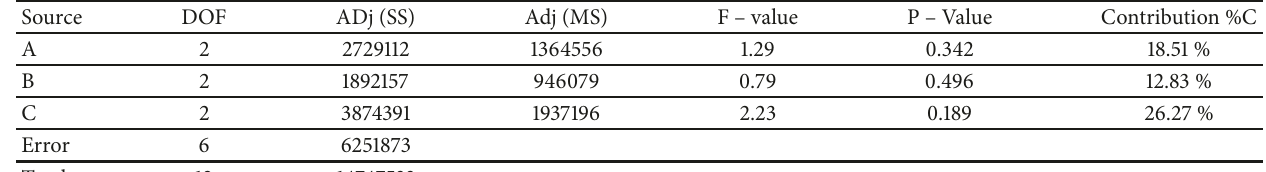
Table 7: Analysis of variance ( ANOVA ) results for MRR (mm 3 /min).